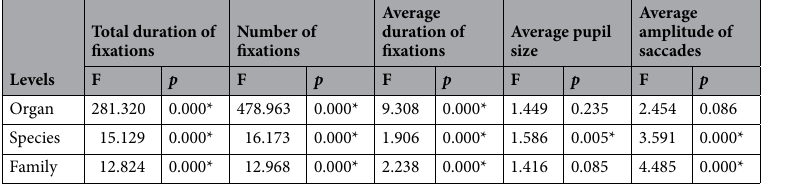
Table 3. Eye movement indexes ANOVA results at family, species, and organ level. *Indicating that there is a difference in the index of this feature.